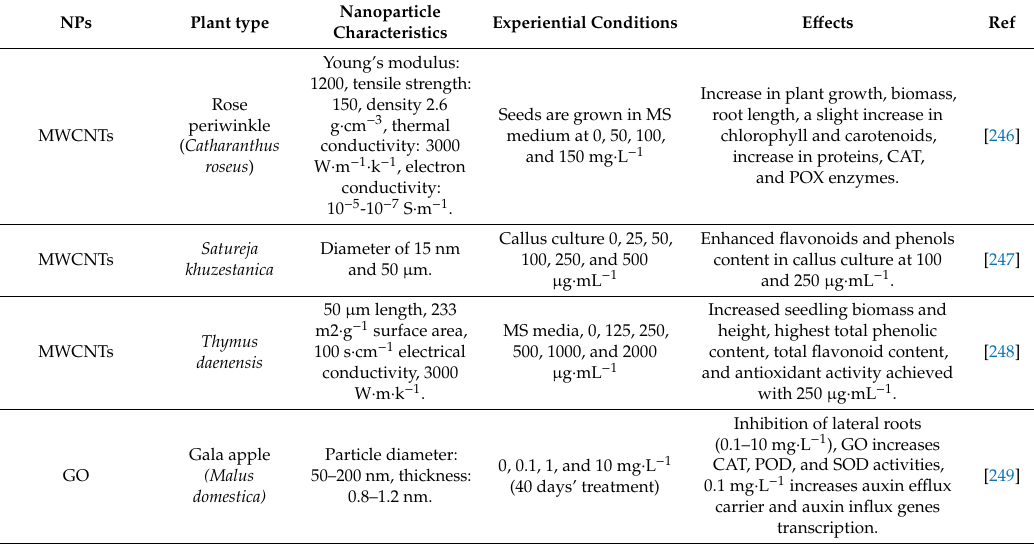
Table 7. Multiple findings toward metabolomics e ff ects in plants due to carbon-based nanomaterials